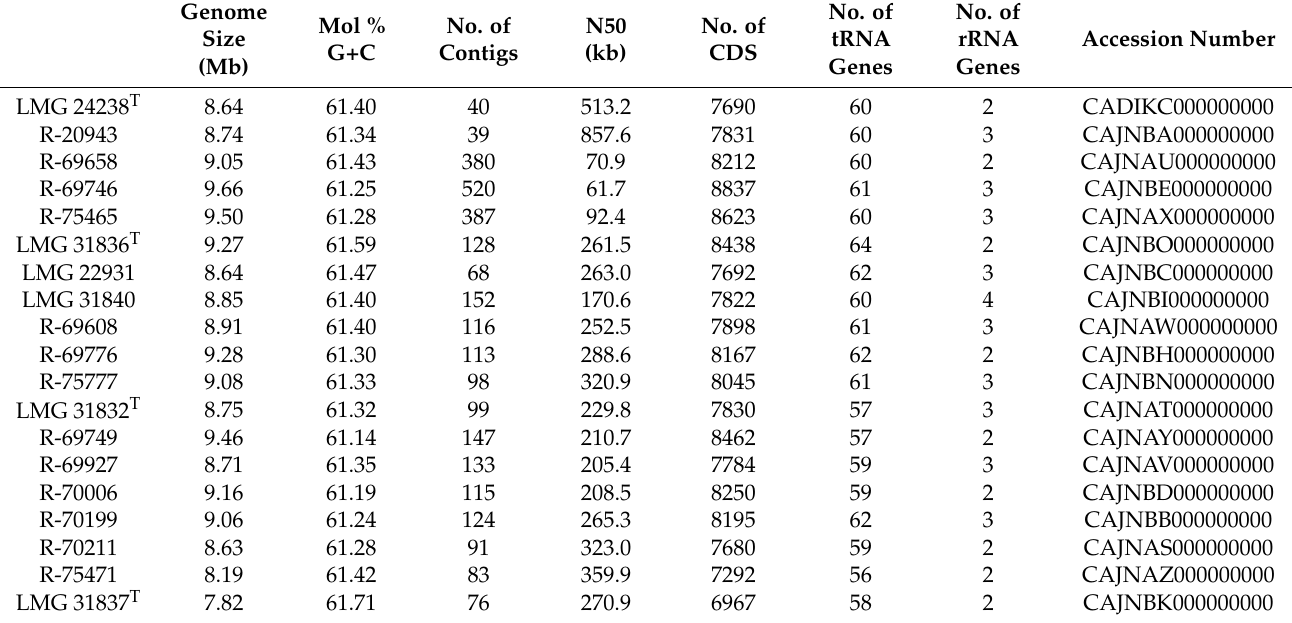
Table 4. Genome features and accession numbers of the final genome assemblies of P. sediminicola LMG 24238 T and of the 18 isolates of the present